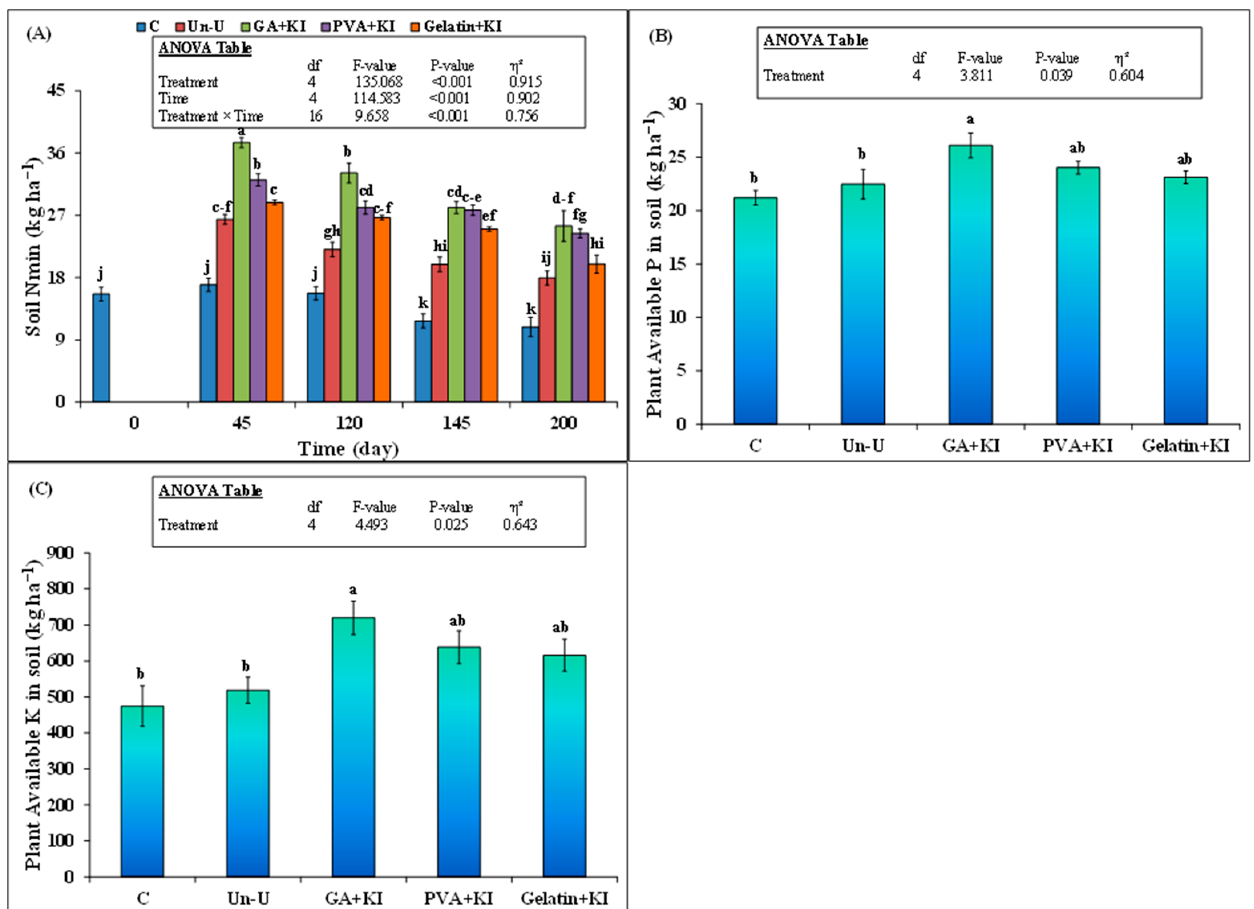
Figure 5. Mean (n = 3) ( A ) soil mineral N on day 45, 120, 145, and 200 ( B ) plant available P and ( C ) K after 200 days of the application of uncoated and coated urea fertilizers. Abbreviations of fertilizer treatments can be seen in Figure 1. C stands for untreated control treatment. Error bars show standard errors ( ± 1 SE) of the mean. Different small letters illustrate significant differences among treatments at a 5% probability level after the Tukey-HSD test. The inset table represents the outcomes of the analysis of variance (ANOVA).